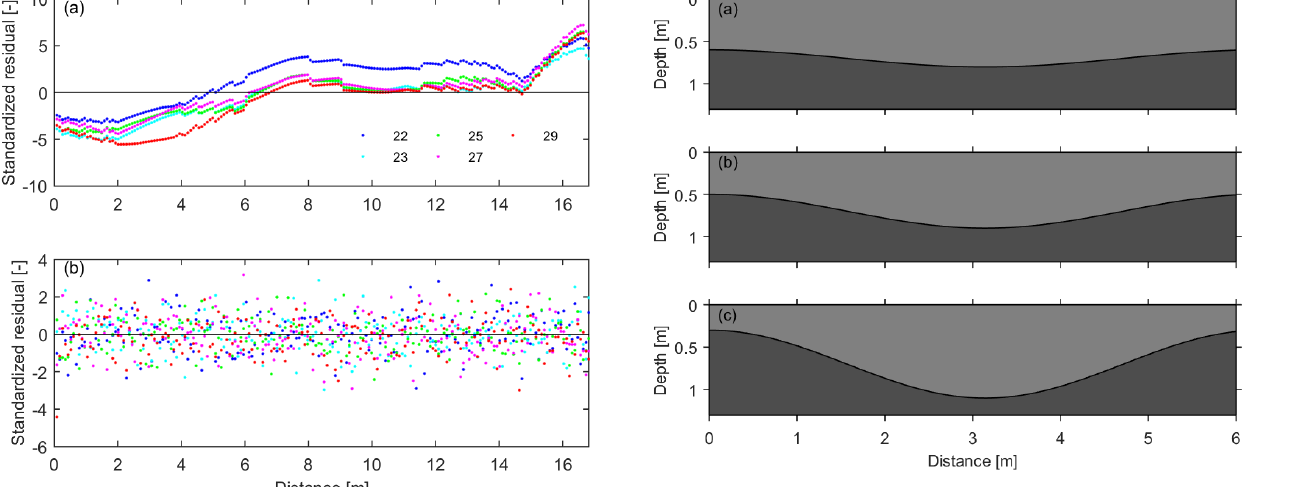
Figure 6. Undulating soil architectures used in synthetic studies for investigating the performance of the proposed approach with differ- ent slope gradients. Three interfaces with different amplitudes are (a) S1, 0.25m; (b) S2, 0.5m; and (c) S3,